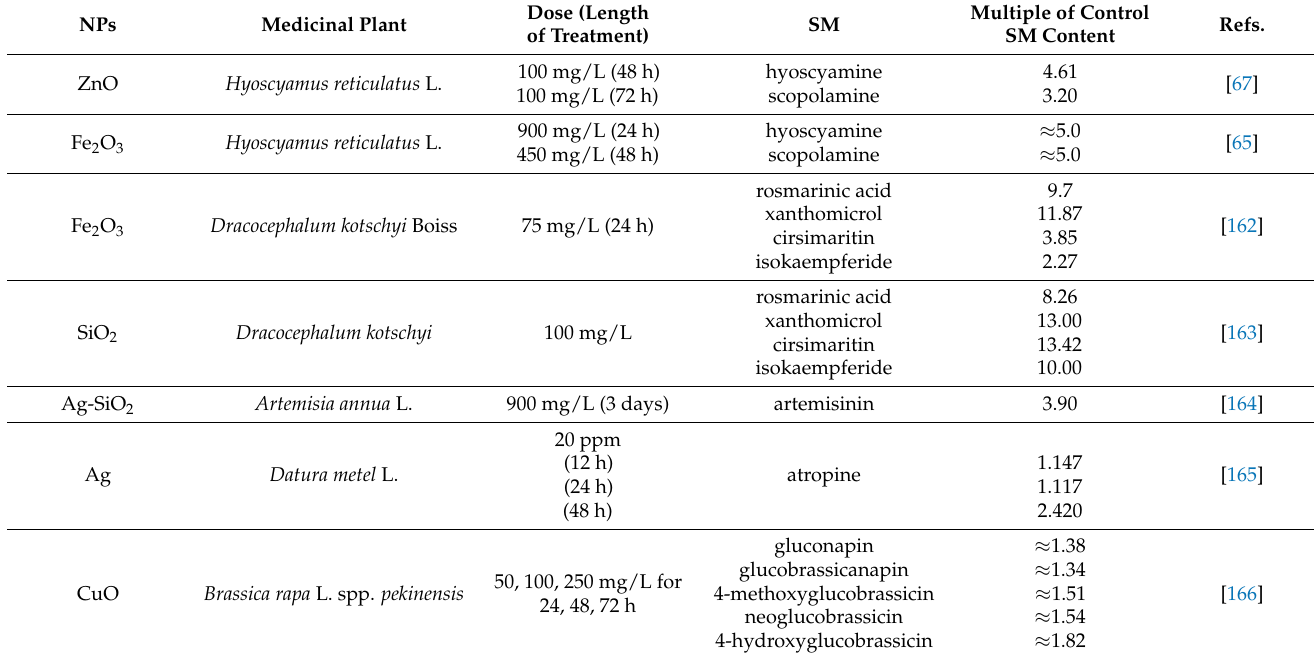
Table 2. Enhanced production of secondary metabolites (SM) of medicinal plants elicited by various NPs using hairy root cultures compared to corresponding bulk